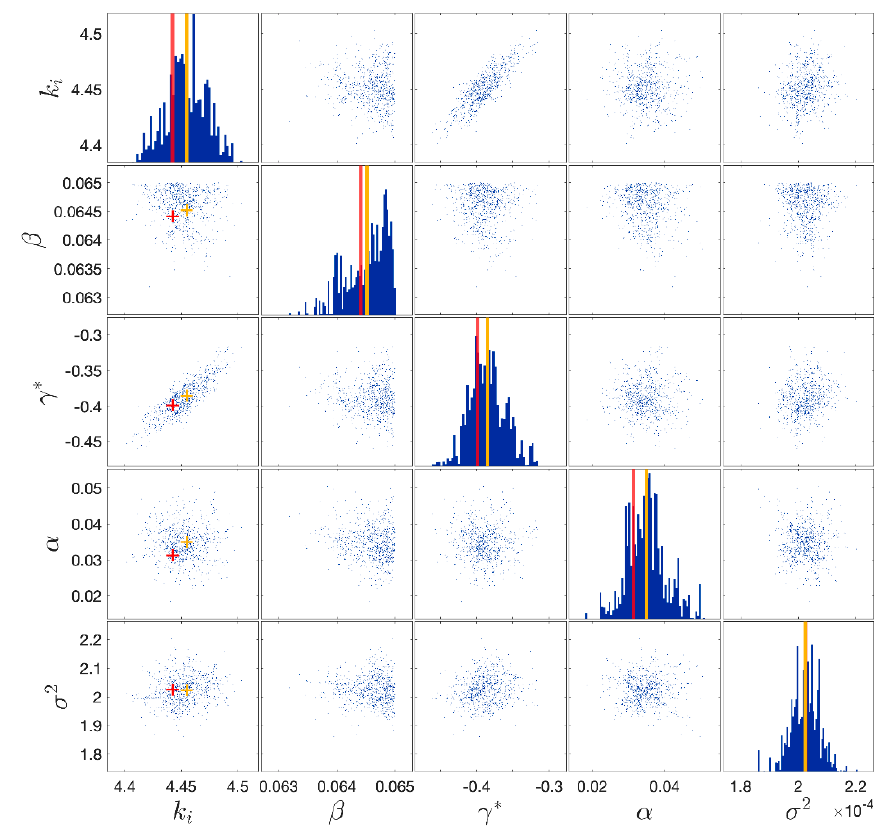
Figure 7. Posterior samples of the BWBN benchmark model parameters. The vertical lines denote the